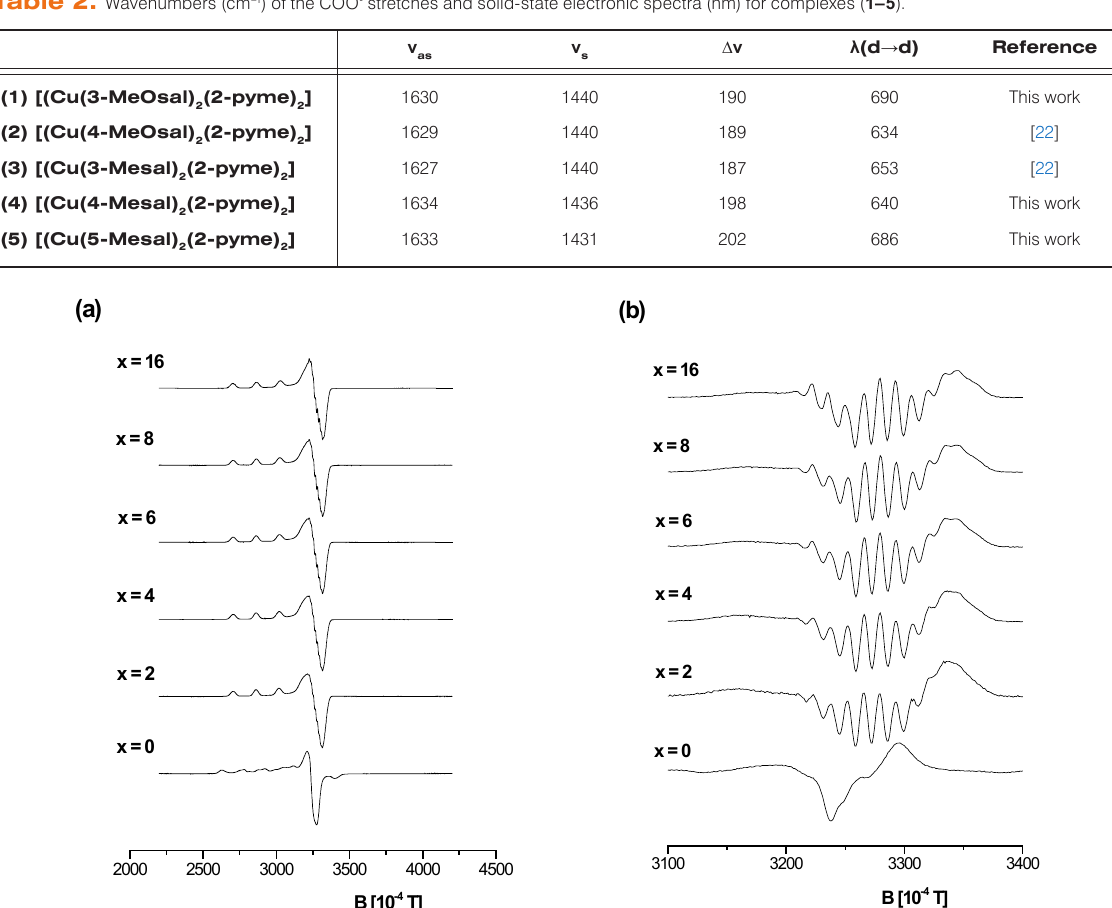
(aq) + 2 (3-MesalH(solv)) + x (2-pyme(l)))], where x = 0, 2, 2